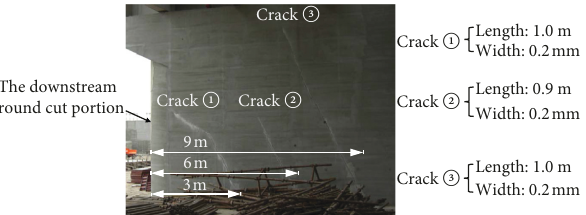
Figure 4: Shapes and positions of the objective cracks.